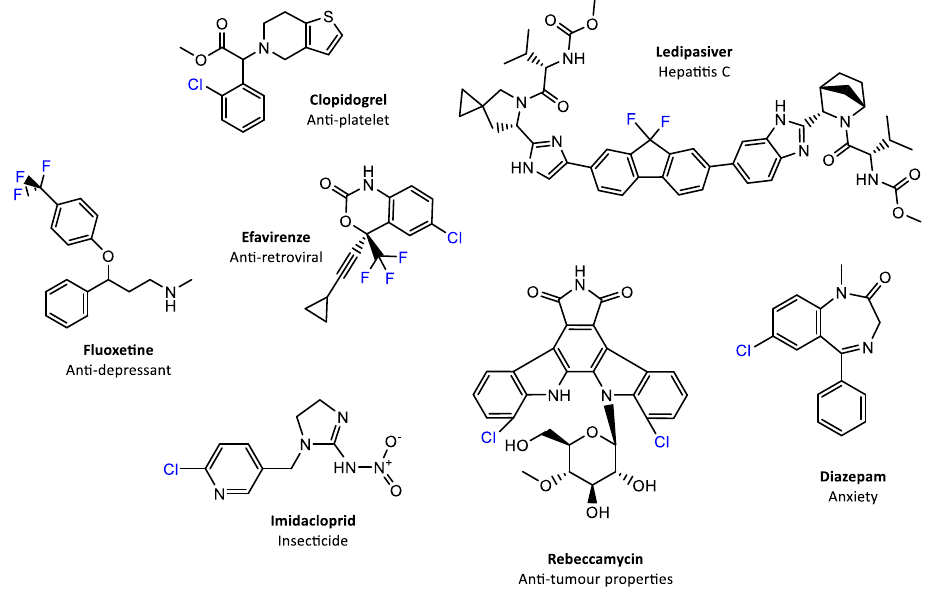
Figure 1. Examples of top-selling halogen-containing pharmaceuticals, agrochemicals, and halogenated natural products with known biological activities.